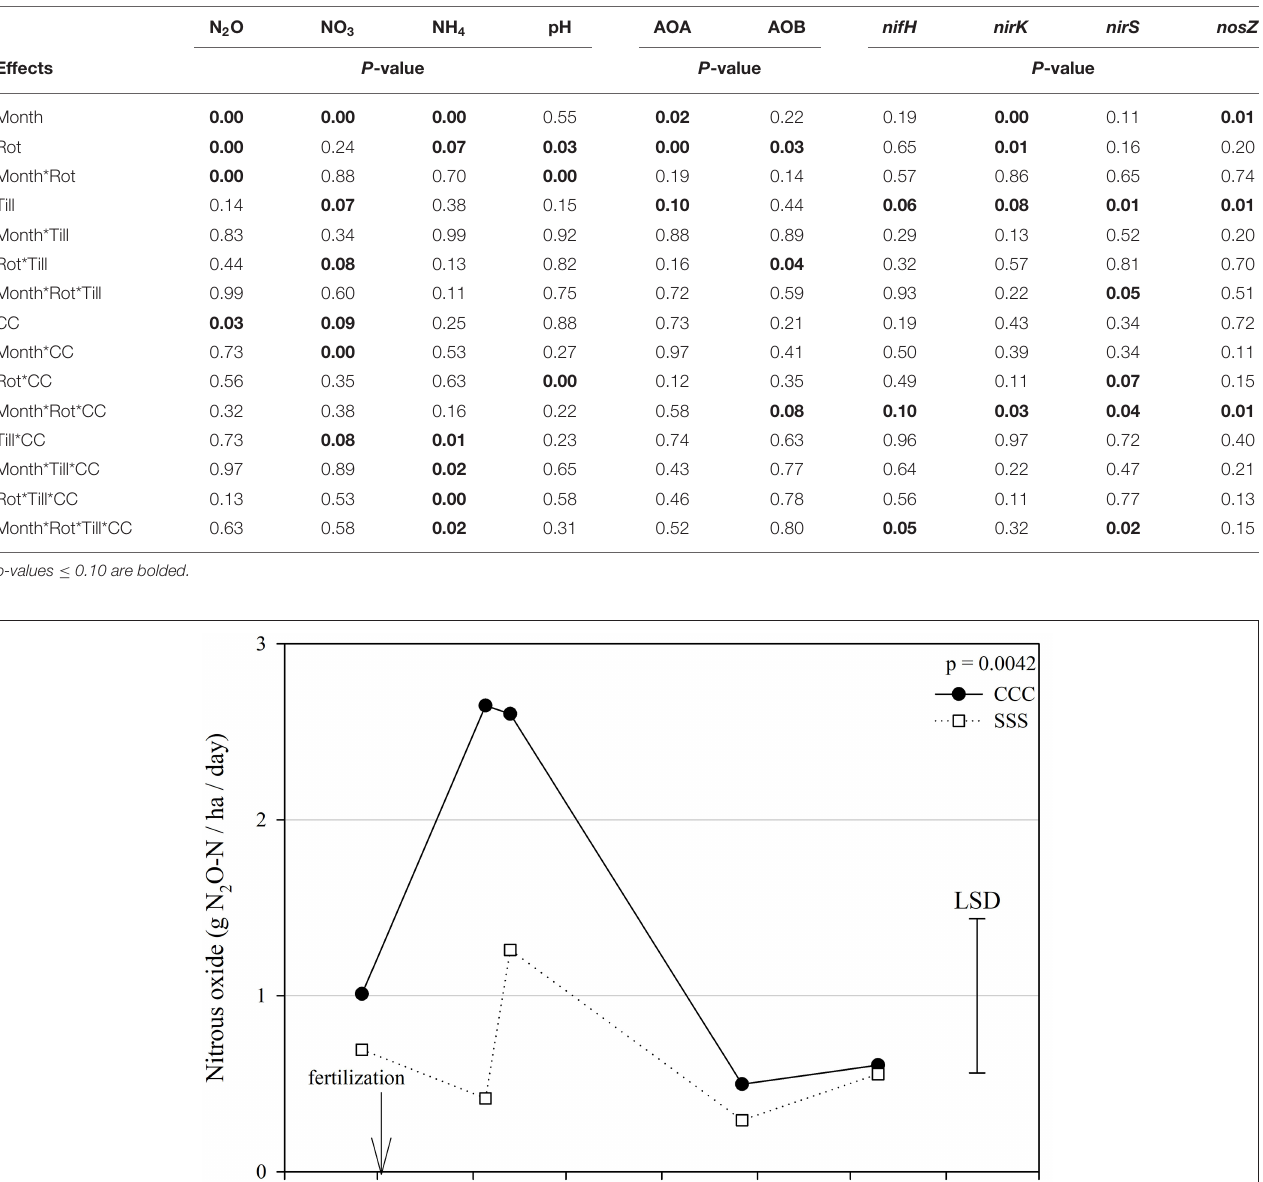
N Cycle Functional